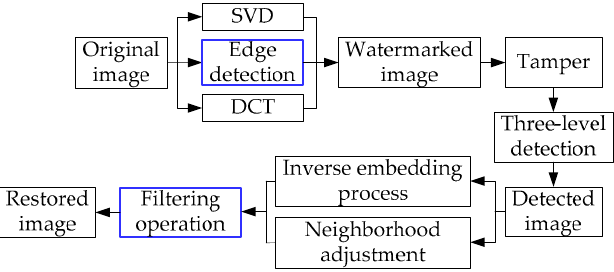
Figure 3. An overview of the proposed method’s tamper detection and recovery process.